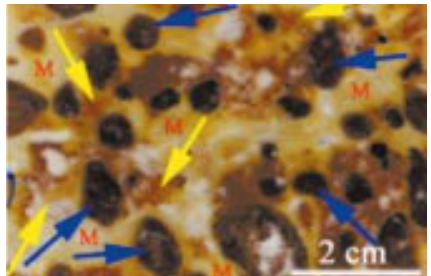
3. Imagem da lâmina correspondente ao horizonte Btf1 do perfil 1. Verifica-se grande quantidade de nódulos concrecionários de ferro (setas azuis) e de manchas plínticas (setas amarelas) na matriz do solo